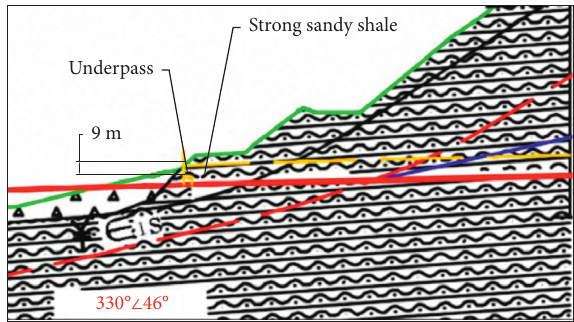
Figure 2: Geological profile of the tunnel.